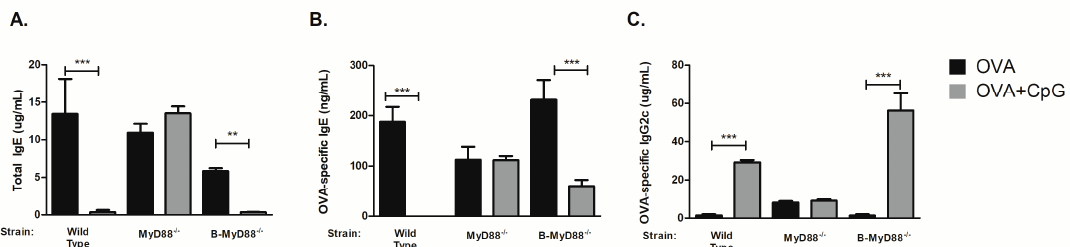
Figure 2. Myd88 expression on B-cells is dispensable for CpG-mediated inhibition of IgE production. C57BL / 6 wild-type (WT) or mice lacking Myd88 expression (MyD88 − / − ) in all cells or in B lymphocytes (B-MyD88 − / − ) mice were subcutaneously sensitized with ovalbumin (OVA) or OVA plus CpG using alum as adjuvant on days 0 and 7 and challenged intranasally with OVA on days 14 and 21. Experiments were performed on day 22. Serum levels of ( A ) Total IgE, ( B ) OVA-specific IgE and ( C ) OVA-specific IgG2c. OVA groups ( n = 5) and OVA + CpG groups ( n = 5). Values represent the mean ± SD and are representative of two independent experiments. One-way ANOVA: ** p < 0.01; *** p < 0.001.